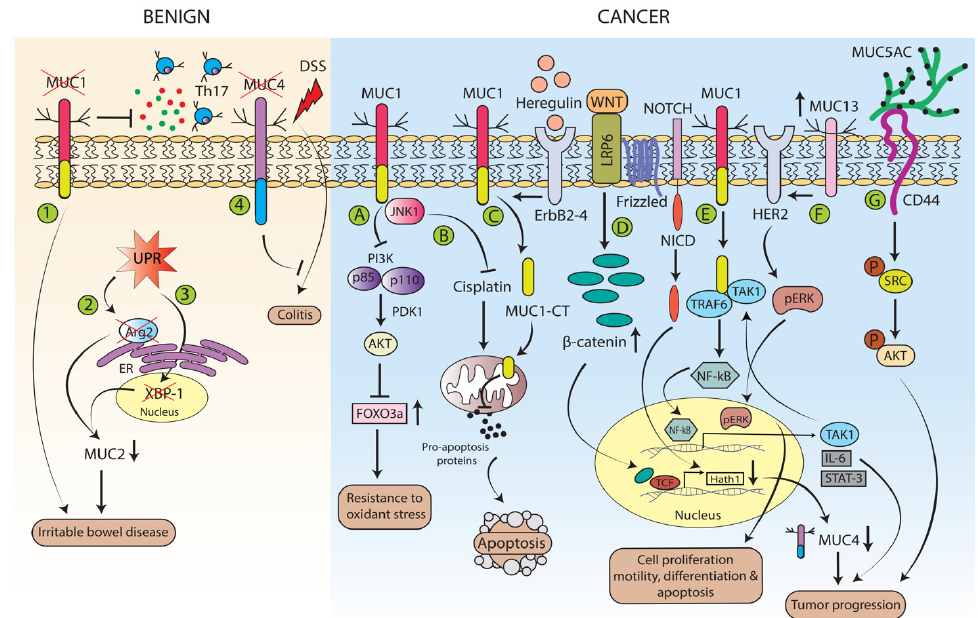
Figure 3. Mucins signaling in the benign and malignant pathologies of the colon. Role of mucins during benign development. ( 1 ) Transmembrane mucin Muc1 upregulated by Th17 to serve as negative regulator of Th17 signaling. During development of Inflammatory bowel disease (IBD) MUC1 downregulation or its variant expression results in disruption of negative feedback leading to aggravation of IBD. ( 2 ) Mucin secreting goblet cells are highly dependent upon the unfolded protein response (UPR) pathway for proper functioning. Loss of key component of UPR machinery including Arg2, XBP1 (key protein involved in proper protein folding) leads to reduction in the expression of MUC2 and in turn affecting development of IBD. ( 3 ) Similarly, downregulation of transcription factor X-box binding protein-1 (XBP-1) in the nucleus results in reduction in MUC2 expression and increases susceptibility to IBD. ( 4 ) Finally, genetically engineered MUC4 knockout mice show increased resistance to Dextran Sodium Sulfate (DSS) induced colitis. Role of mucins during CRC development. ( A ) MUC1 via PI3K/AKT pathway attenuate phosphorylation of FOXO3 that is involved in inducing oxidative stress in colon cancer cells activity. Overall MUC1 downregulation enhance apoptosis of colon cancer cells. ( B ) The C-terminal domain of MUC1 (MUC1-CT) interacts with JNK1 and attenuate cisplatin-mediated apoptosis. ( C ) Upon induction of ErbB by Heregulin, MUC1-CT is released, and it translocate to the mitochondria to prevent stress-induced apoptosis. ( D ) Binding of Wnt ligand to its receptors i.e. LDL Receptor Related Protein 6 (LRP6) and Frizzled receptor leads to nuclear accumulation of β -catenin which inhibits Hath1 expression via Hes1 (not shown here) along with notch intracellular domain (NICD) results in reduced expression of MUC4 in CRC. ( E ) MUC1-CT interacts with TAK1/TRAF6 complex to induce NF κβ -mediated tumor-promoting gene transcription. ( F ) Over-expression of MUC13 potentiates Her2 signaling and induces ERK-mediated upregulation of genes governing cell proliferation, motility, differentiation and apoptosis. ( G ) Physical interaction of secretory mucin MUC5AC with transmembrane protein CD44 enhanced CRC progression through activation of Src signaling.